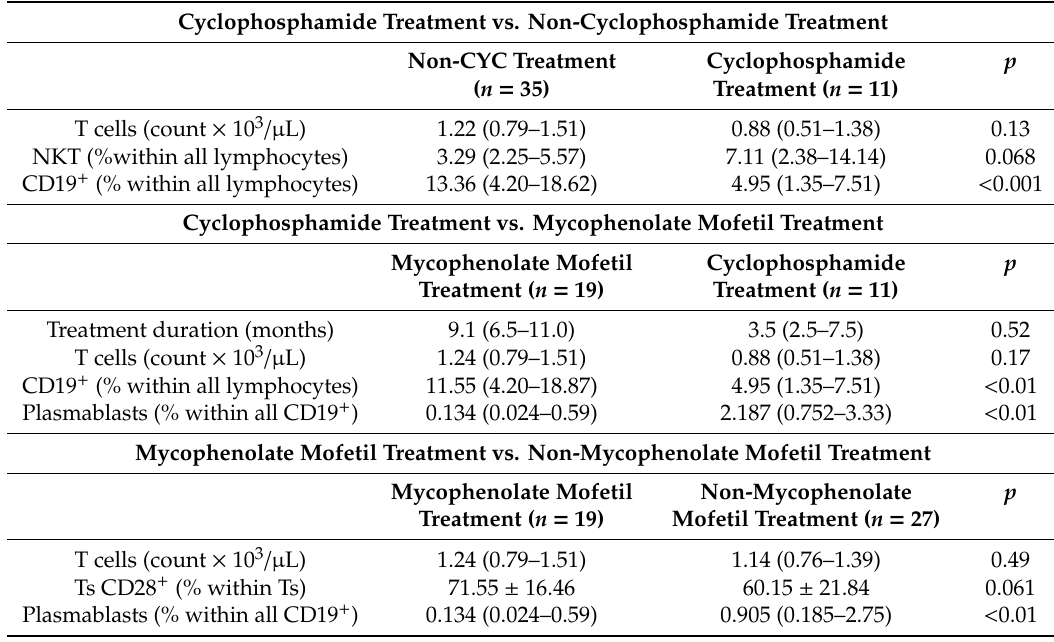
Table 6. Impact of treatment with cyclophosphamide and mycophenolate mofetil on immune cells in patients with systemic